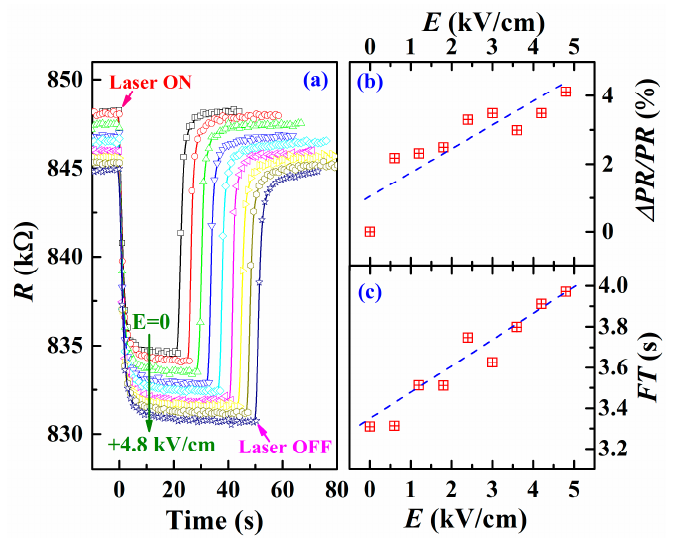
Figure 4. ( a ) In situ photo responses of the LMO film under different positive E applied to the posi- tively polarized PMN-PT (from 0 to +4.8 kV/cm). The Δ PR/PR ( b ) and RT ( c ) as functions of the polarized PMN-PT (from 0 to +4.8 kV/cm). The ∆ PR/PR ( b ) and RT ( c ) as functions of the electric electric field E . field E